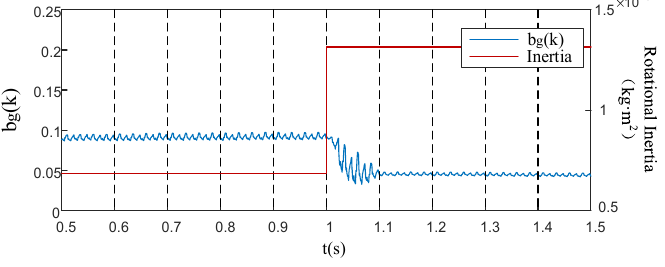
Figure 4. The tendency of parameter 𝑏 (cid:3034) (cid:4666)𝑘(cid:4667) . The mean error Δ𝑏 (cid:3034)∗ (cid:4666)𝑘(cid:4667) of 𝑏 (cid:3034) (cid:4666)𝑘(cid:4667) is calculated by (12) and (13), as follows: (12)